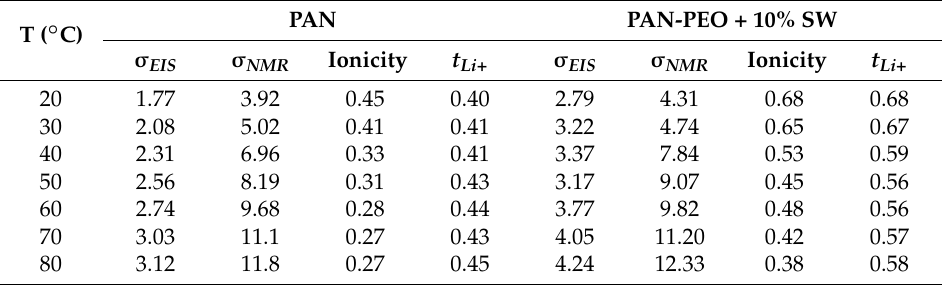
Table 1. Comparison between σ EIS and σ NMR (in Ms cm − 1 ), ionicity index and lithium transport number for PAN and PAN:PEO/org-SWy